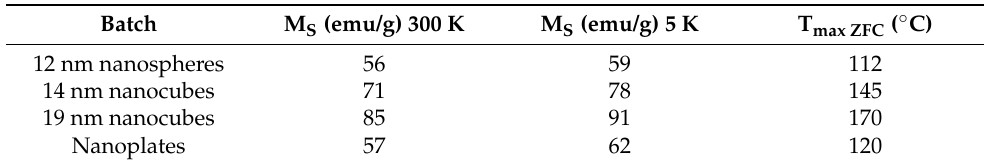
Figure 2. Magnetization curves at ( A ) 300 K and ( B ) at 5 K (inset: zoom around 0 T) of different IONPs. ( C ) ZFC/FC curves under a magnetic field of 7.5 mT (75 Oe) and ( D ) derivative of ZFC/FC curves, with the Verwey transition highlighted in yellow. Table 2. Saturation magnetizations (M S , measured at 300 K and 5 K) and the maximum of the ZFC curve (T max ZFC ) assimilated as the blocking temperature of the various